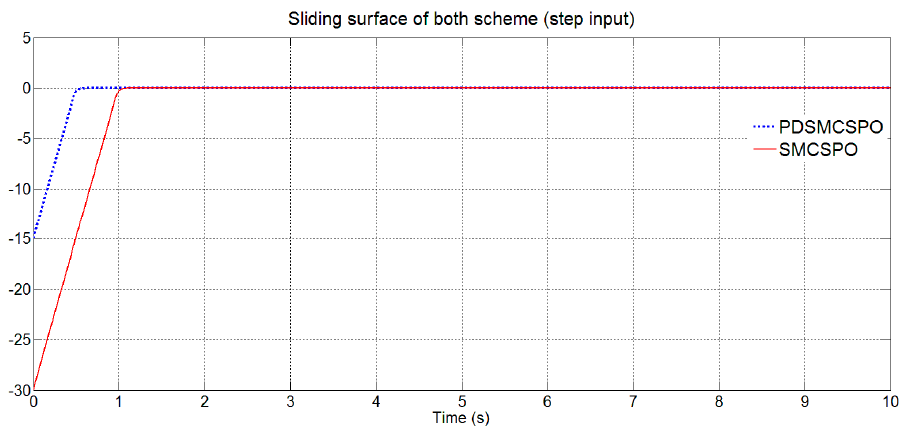
Figure 13. Sliding surface response of both schemes.